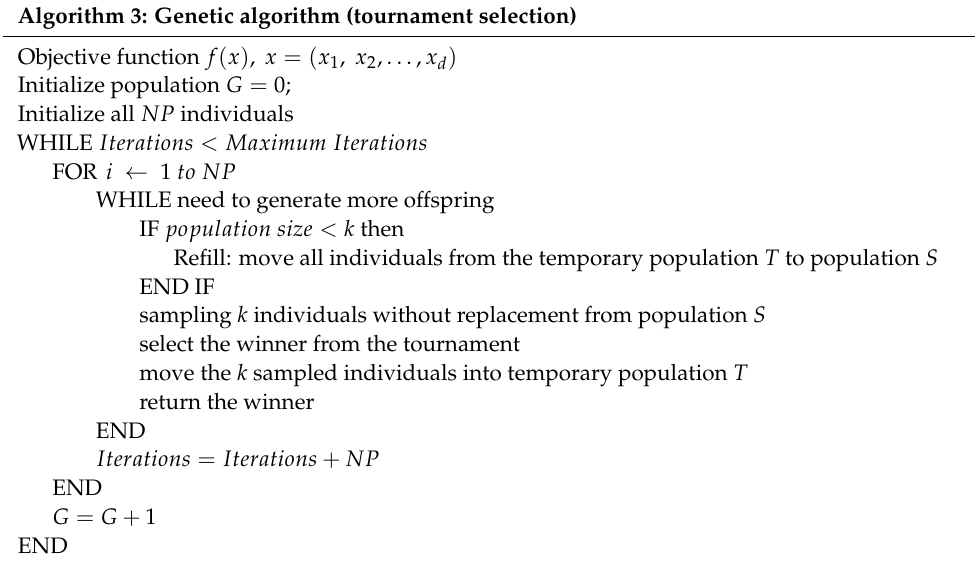
Algorithm 3: Genetic algorithm (tournament selection)